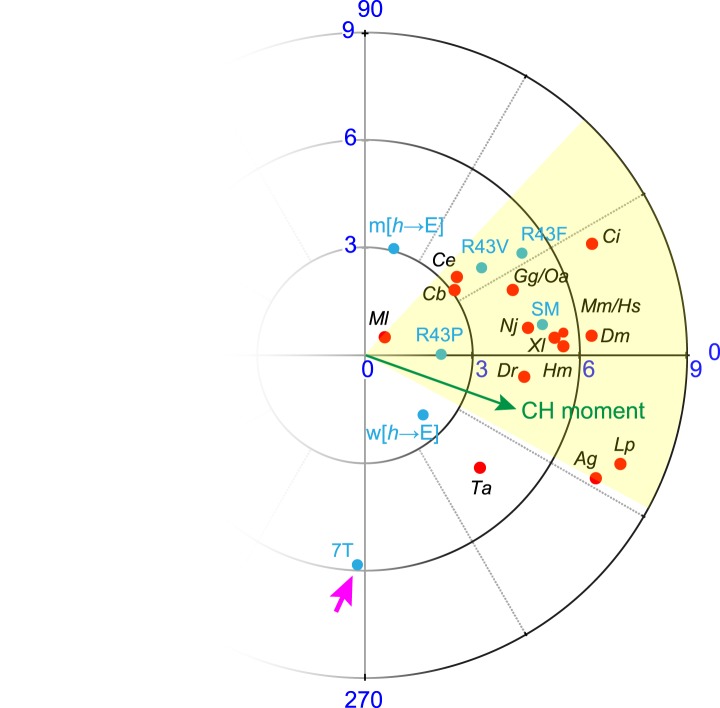
Hydrophobic moments of functional and nonfunctional CPX transgenes.Polar plot of hydrophobic moments for the AH domain of CPX-1 variants. The CPX-1 variants (blue) are mouse AHshort (SM), worm AH with hydrophobic to glutamates (w[h→E]), mouse AH with hydrophobic to glutamates (m[h→E]), 7-turn helix substitution (7T), as well as the R43P, R43F, and R43V substitutions. The moment of the worm CH is shown in green. 7T construct designated with a pink arrow. The hydrophobic moments of 16 species from Figure 3—figure supplement 1 are included for comparison.